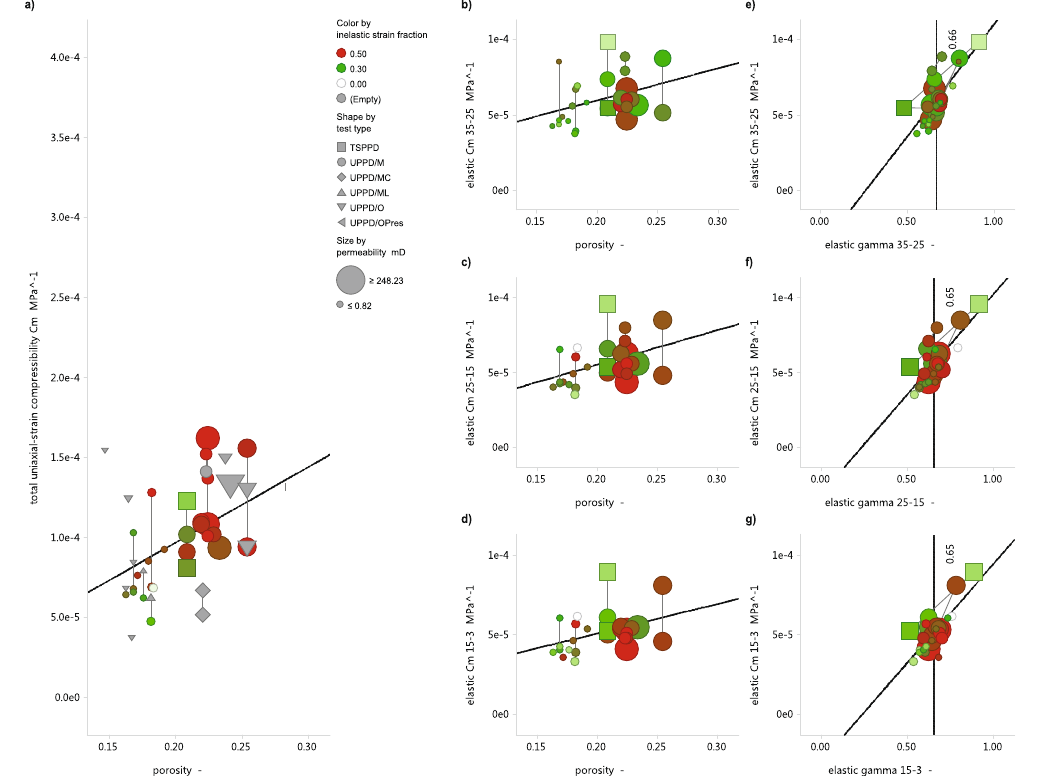
Figure 3. ( a ) Total uniaxial-strain compressibility C m for all tested samples parameterized based on the axial strain and pore pressure change presented in Fig. 1. Shape indicates the various loading protocols employed, with the multicycle Uniaxial-strain Pore Pressure Depletion (UPPD/M) being the most used. Color gradients indicate the fraction of inelastic strain between 0 and 0.3 (white-green), and 0.3–0.5 (gree-red). Note, the clear increase in C m with increasing porosity, as well as the higher permeability and larger fraction of inelastic strain at high C m . ( b – d ) Uniaxial-strain compressibility C m for each depletion step (pore pressures 35 MPa-25 MPa, 25 MPa-15 MPa, and 15 MPa-3 MPa), as parameterized using the final inflation cycle versus the porosity. Note, the consistent, depletion-independent increasing trend, which suggests that the elastic response in independent of the stress history. ( e – g ) Uniaxial-strain compressibility C m for each depletion step versus the measured γ h for all samples. The mean γ h around 0.66, and the data spread, is in line with expected linear poroelastic behavior. Note, that also the TSPPD tests, where a value for γ h was imposed rather than measured, are part of the same